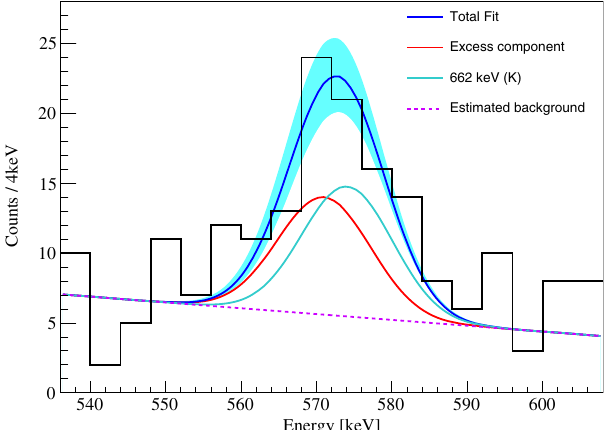
Fig. 5 Close-up of the recoil-gated, α -tagged electron energy spectrum around 570 keV. The total fi t (blue) includes two components, one is ! 0 þ associated with the 2 þ transition (cyan) and the other with the 1 1 ! 0 þ 0 þ transition (red). The uncertainty of the total fi t at the 1 σ level is 3 1 shown with light blue band. The purple dashed line illustrates the extracted